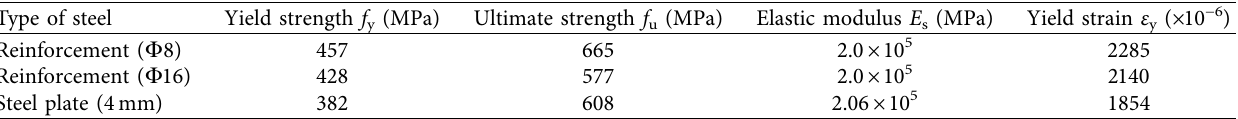
Figure 4: Dimensions, reinforcements, and construction of the tested specimens. (a) Dimensions and reinforcements of slabs. (b) Section 1- 1 of Specimen BGJ1. (c) Section 1-1 of Specimen BGJ2. (d) Section 2-2 (Specimen BGJ1 and BGJ2). (e) Connection pattern of girder and beams. (f) Seams of beam and shaped sleeve. (g) Seams of girder and shaped Table 1: Mechanical properties of steel and reinforcement.